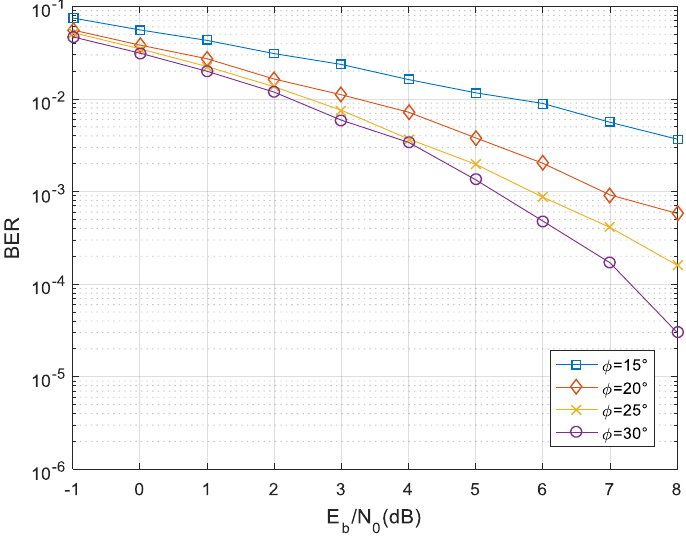
Figure 9. The BER (Bit Error Rate) under different elevation angle.